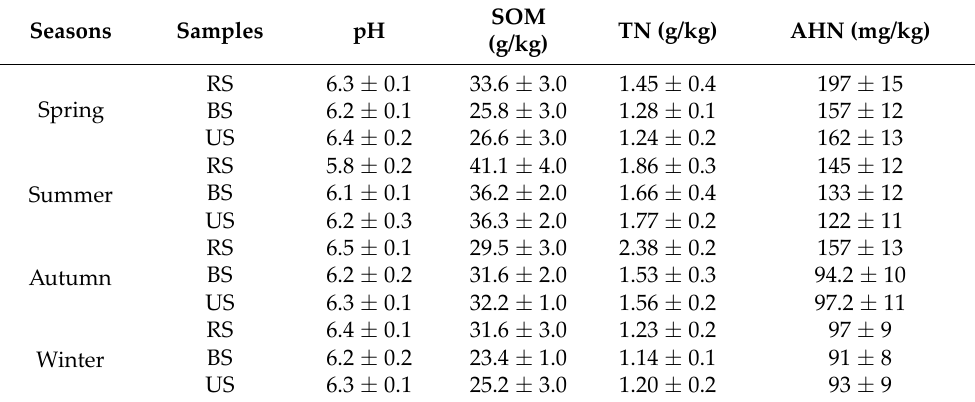
Abbreviations: BS—bulk soil; RS—rhizosphere soil; US—uncultivated soil; SOM—soil organic matter; TN—total nitrogen; and AHN—alkali‑hydrolyzed nitrogen. PCA plot shows that the first two principal components (PCs) accounted for 76.2% of the total variation in soil chemical properties (PC1: 47.4%; PC2: 28.8%) (Figure 1). Soil pH was significantly associated with both PC1 ( p = 0.031) and PC2 ( p = 0.016). SOM and TN were associated with PC1 remarkably (SOM: p < 0.001; TN: p = 0.009), whereas AHN exhibited a strong association with PC2 ( p = 0.012).